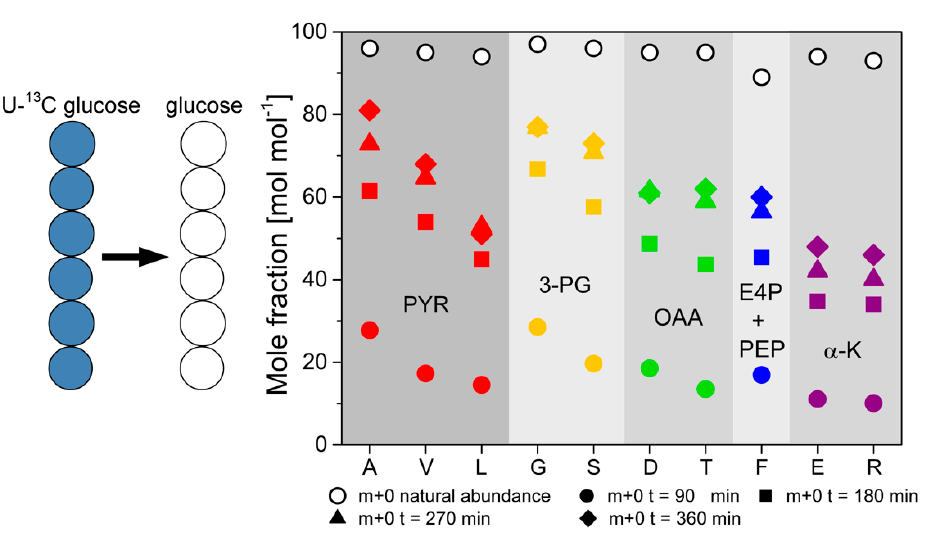
Figure 11. 13 C-labeling dynamics of 10 different amino acids in secreted phytase from H. polymorpha RB11 conphys cultivated in glucose-limited continuous cultivations. The dynamics were measured under non-stationary isotopic conditions upon the change from 100% (mol/mol) U- 13 C glucose to 100% (mol/mol) naturally labeled glucose at a dilution rate of D = 0.2 h − 1 . The amino acids are classified according to their precursor metabolites from the central carbon metabolism. (A = alanine, G = glycine, V = valine, S = serine, T = threonine, F = phenylalanine, D = aspartate, E = glutamate, L = leucine, R = arginine).